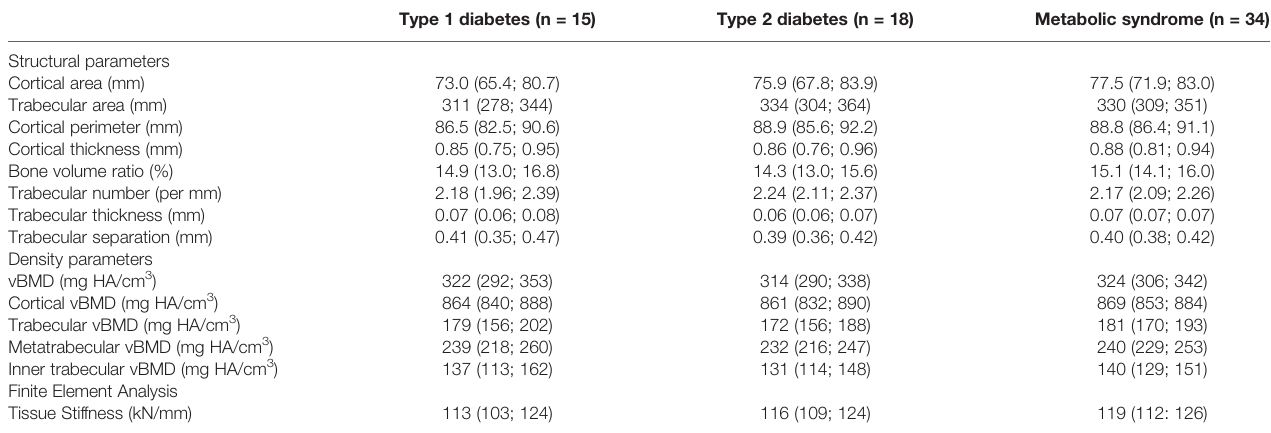
TABLE 3 | Results from high resolution peripheral quantitative CT of the